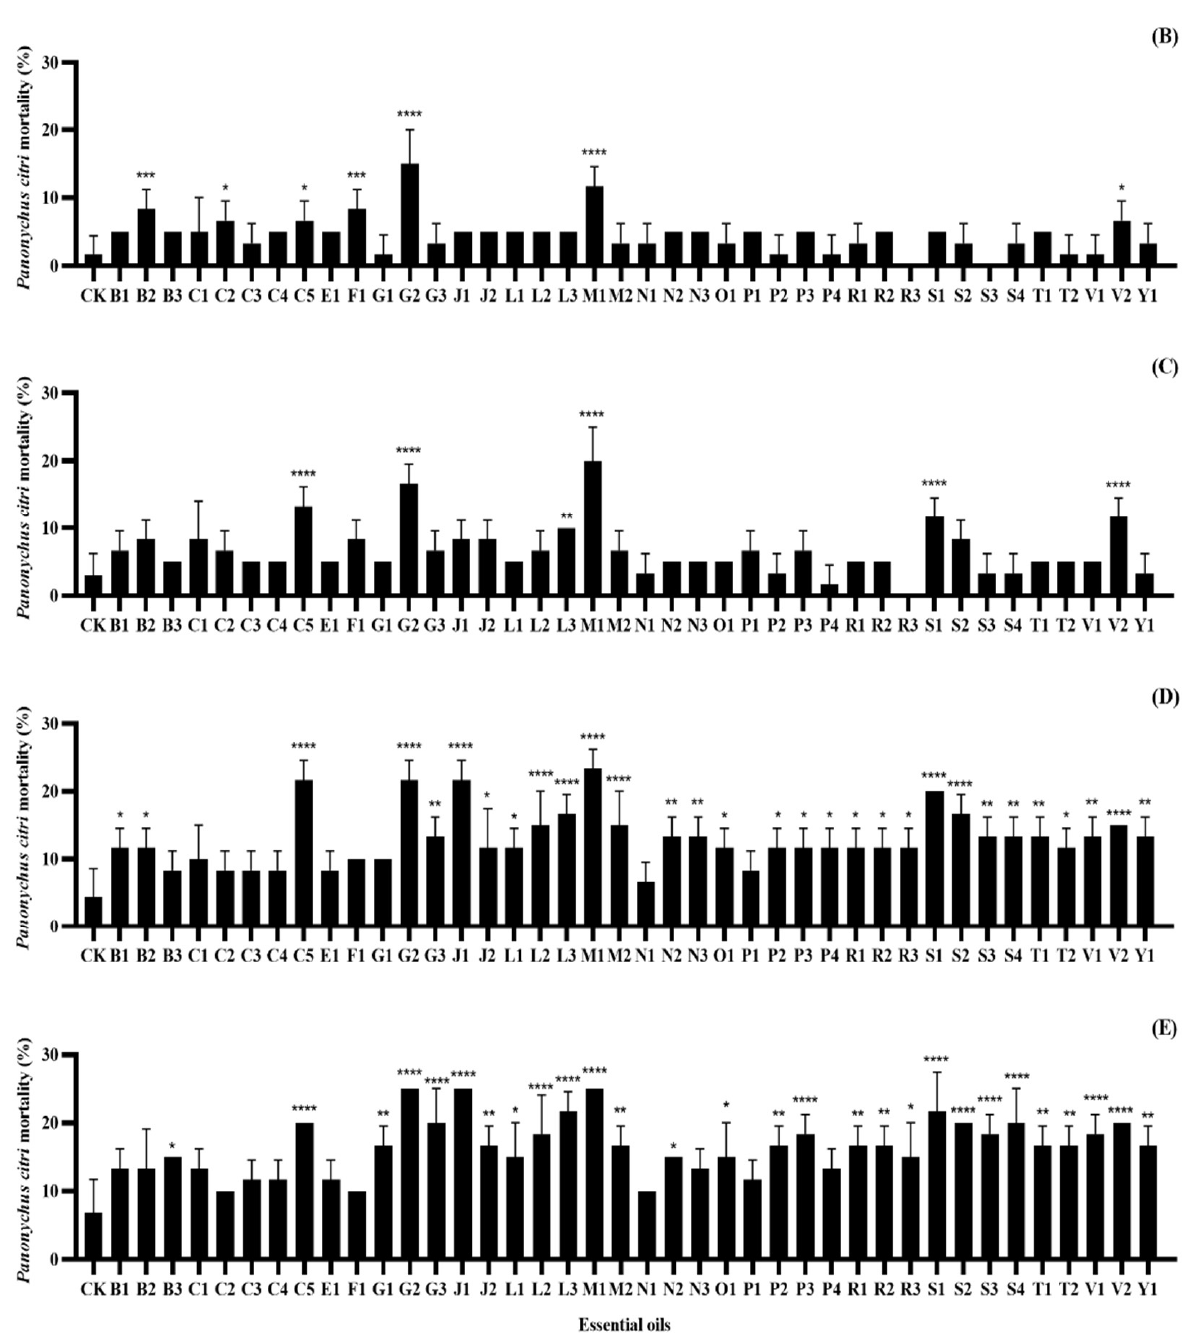
Figure 1. The lethal situation of 1 µ L/mL essential oils against Panonychus citri at different times. ( A – E ) Mortality rates of Panonychus citri in leaf-dip bioassay after 6 h, 12 h, 24 h, 48 h, and 72 h, respectively. The error bars denote the standard deviation. * p ≤ 0.05; ** p ≤ 0.01; *** p ≤ 0.001; **** p ≤ 0.0001.